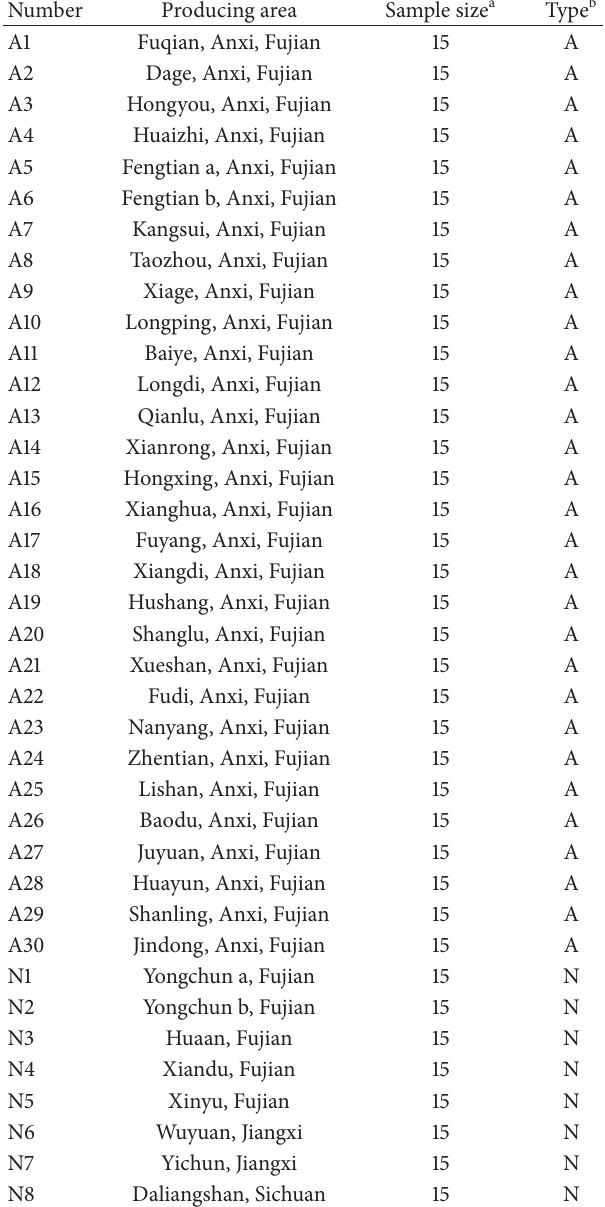
Table 1: Analyzed tea